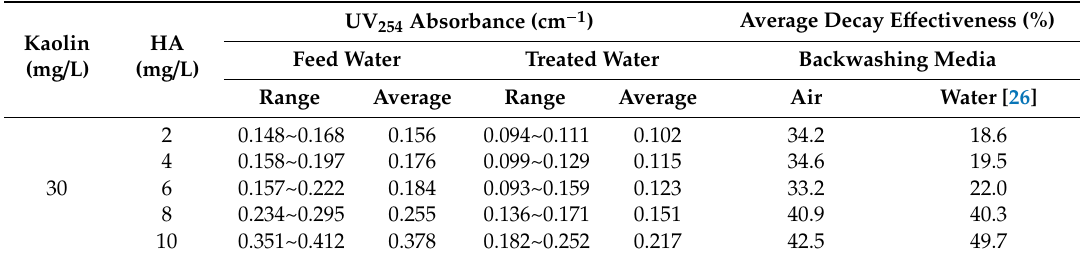
Table 8. Decay e ff ectiveness of dissolved organic matter (UV 254 absorbance) for e ff ect of humic acid in the integrated system, of multichannel ceramic MF and pure PP particles, using air backwashing (FT 10 min, BT 10 s); paralleled with consequences of water